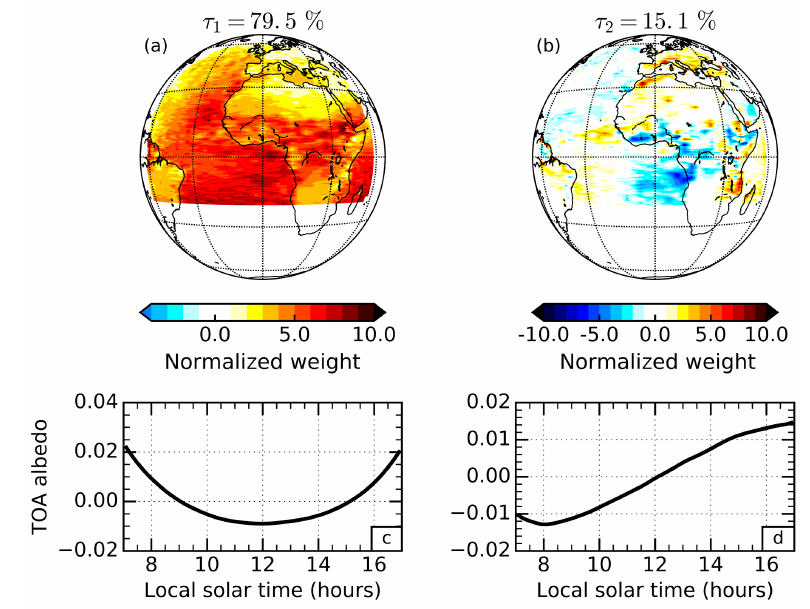
Figure 8. Principal component analysis of the top-of-atmosphere (TOA) albedo diurnal cycle for July 2006 in observations from the Geosta- tionary Earth Radiation Budget instrument. The empirical orthogonal functions ( a and b ) and principal components ( c and d ) are presented for the first ( a and c ) and second ( b and d ) most dominant patterns of variability. The percentage variance explained by each mode is stated above the corresponding empirical orthogonal function.